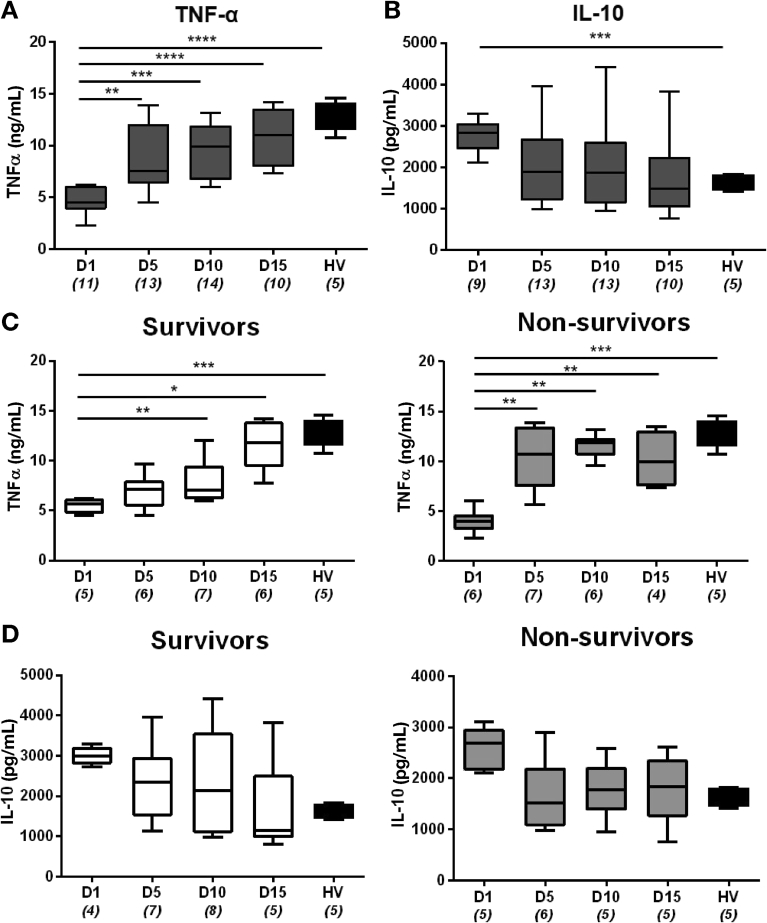
Distinct immune restoration phenotype associated with survival develops over time. Levels of TNF-α (A and C) and IL10 (B and D) secreted by MDMs were quantified by enzyme-linked immunosorbent assay. Cells were sensitized with plasma from ATTIRE survivors, non-survivors, and healthy volunteers (HV) for 30 minutes and stimulated with 100 ng/mL lipopolysaccharide for 4 (A and C) and 24 (B and D) hours. Boxes represent median with upper and lower quartiles. Bars represent minimum and maximum observations. Numbers of samples used for each day are written in parentheses. *P < .05, **P < .01, ***P < .001. Significance determined by using one-way analysis of variance and Bonferroni adjusted pairwise t tests. ATTIRE, Albumin to Prevent Infection in Chronic Liver Failure; IL, interleukin; MDM, monocyte-derived macrophage; TNF, tumor necrosis factor.